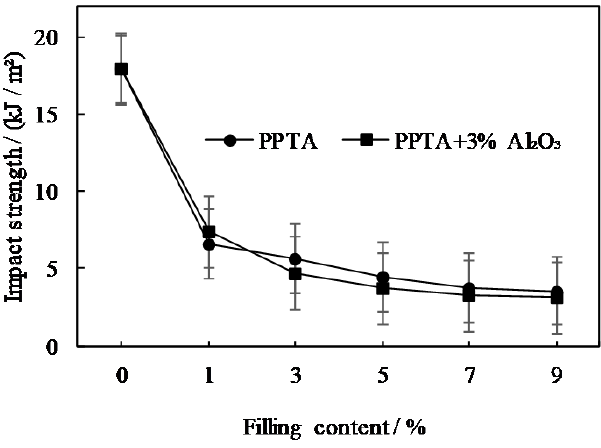
Figure 16. Impact performance of PPTA and nano Al 2 O 3 particles filled modified PTFE composites.